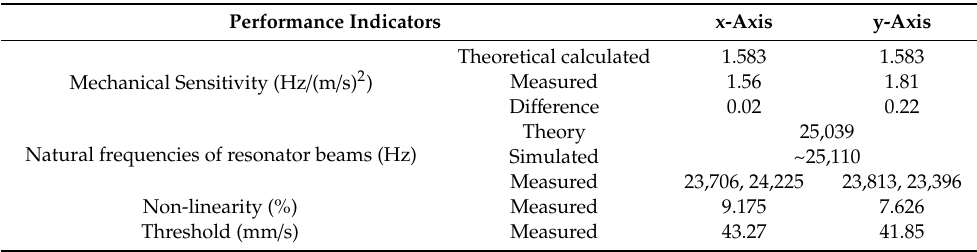
Figure 15. The outputs of the hair flow sensor under oscillatory air flow. ( A ) Sensitivity on the x-axis. ( B ) Sensitivity on the y-axis. Table 4. Performance